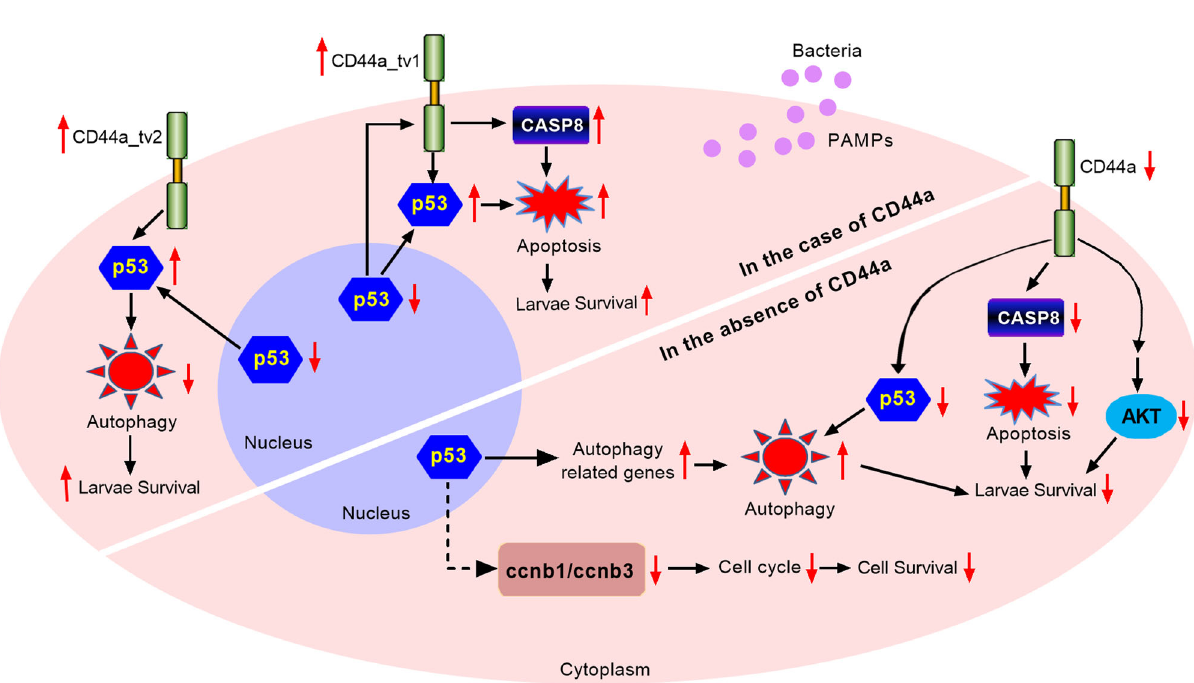
Fig. 9 Proposed model illustrating the different antibacterial mechanisms of zebra fi sh CD44a variants during E. piscicida infection. CD44a de fi ciency regulates the expression levels of many genes involved in p53 signaling, apoptosis and autophagy, which leads to inhibition of apoptosis and induction of autophagy in the case of E. piscicida infection. In zebra fi sh, two CD44a variants including CD44a_tv1 and CD44a_tv2 are identi fi ed. The zebra fi sh CD44 variants exert protective effects against E. piscicida infection. Both zebra fi sh CD44a_tv1 and CD44a_tv2 can promote the nucleoplasmic translocation of p53 and interact with p53 in the cytoplasm. The antibacterial effect of zebra fi sh CD44a_tv1 is depending on the CASP8-mediated apoptosis, whereas the antibacterial effect of zebra fi sh CD44a_tv2 is dependent of the cytoplasmic p53-mediated inhibition of